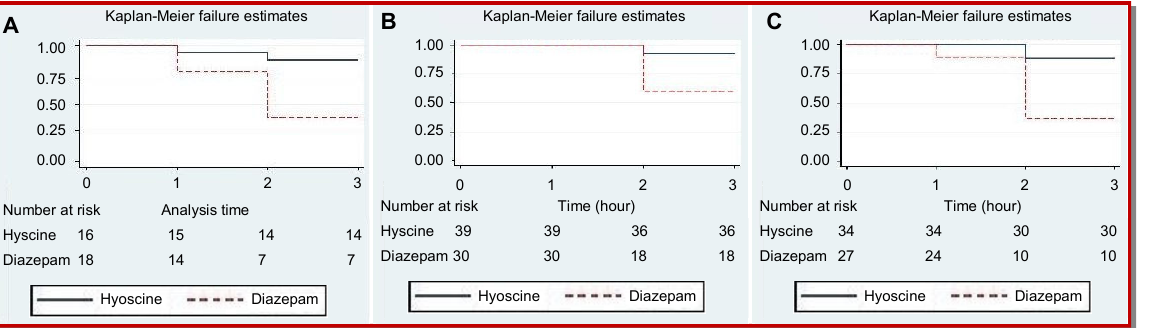
Figure 2: Complete vertigo relief failure rate of hyoscine and diazepam in treating vertigo in supine position (A), in sitting position (B), and while turning the head